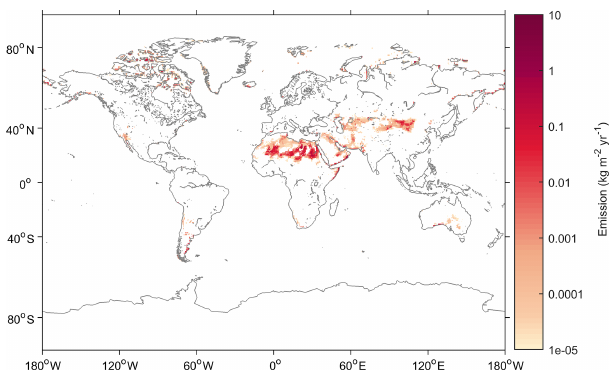
Figure 6. Average annual dust emission for the period 1990–2012 estimated with FLEXDUST driven with ERA-Interim